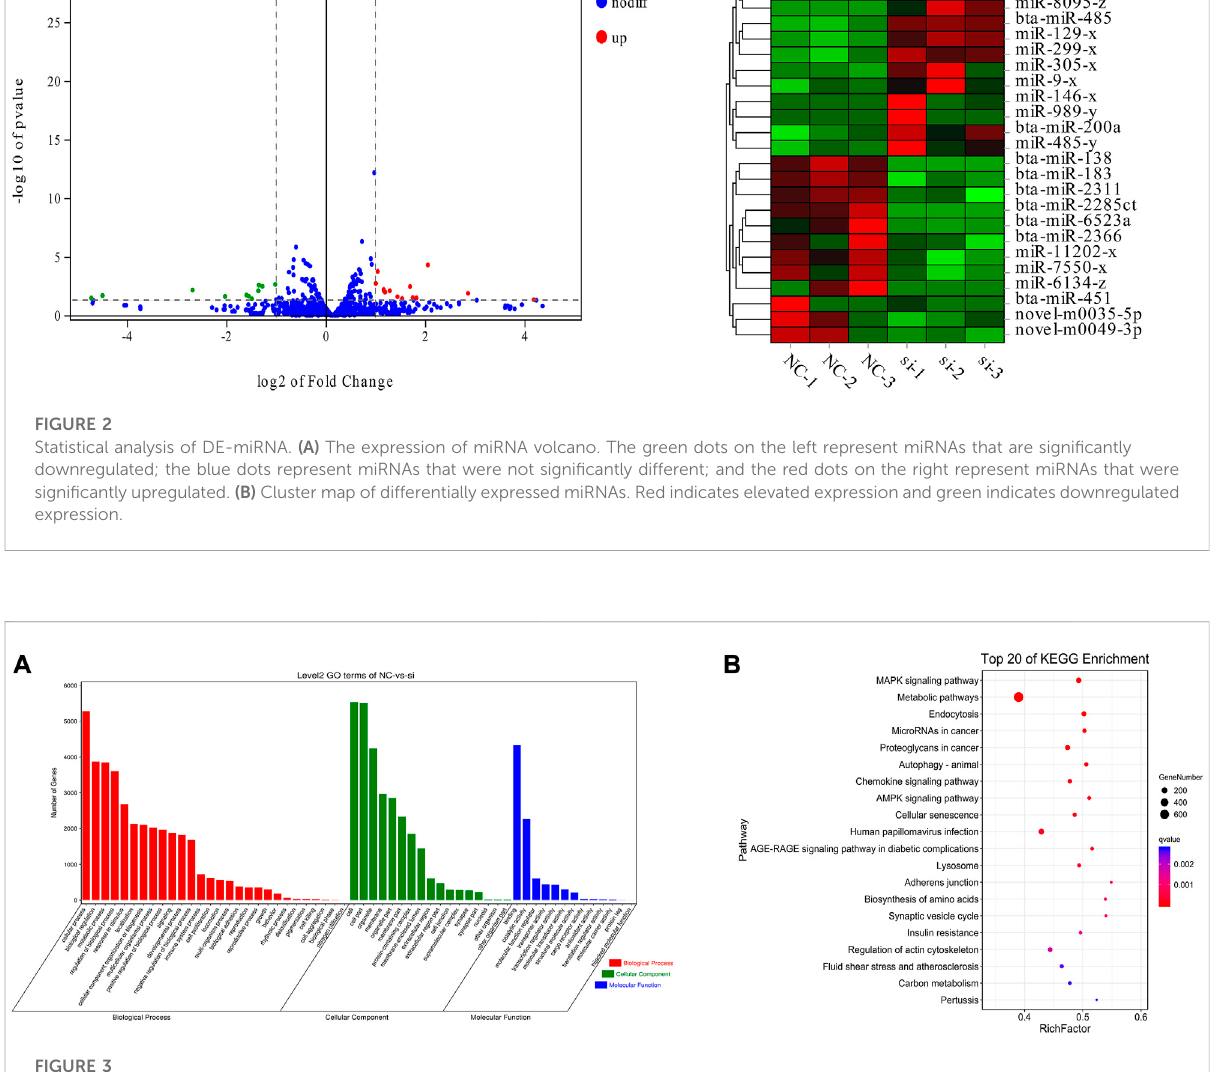
FIGURE 3 Functional enrichmentanalysis ofDE-miRNAs. (A) GO enrichmentanalysis oftarget genesof DE-miRNAs. (B) Top 20KEGG signaling pathways enriched by DE-miRNAs target